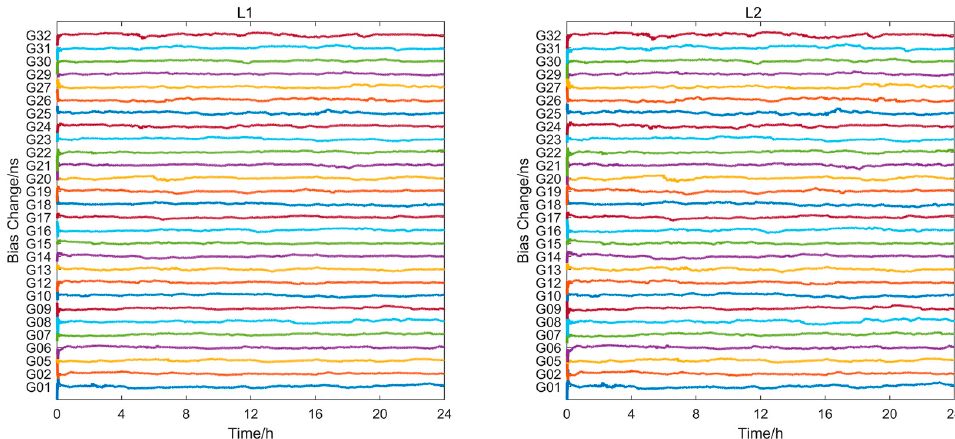
Figure 3. Time series of the observable-specific signal bias at L1 and L2 frequencies of the GPS for DOY 301, 2021.